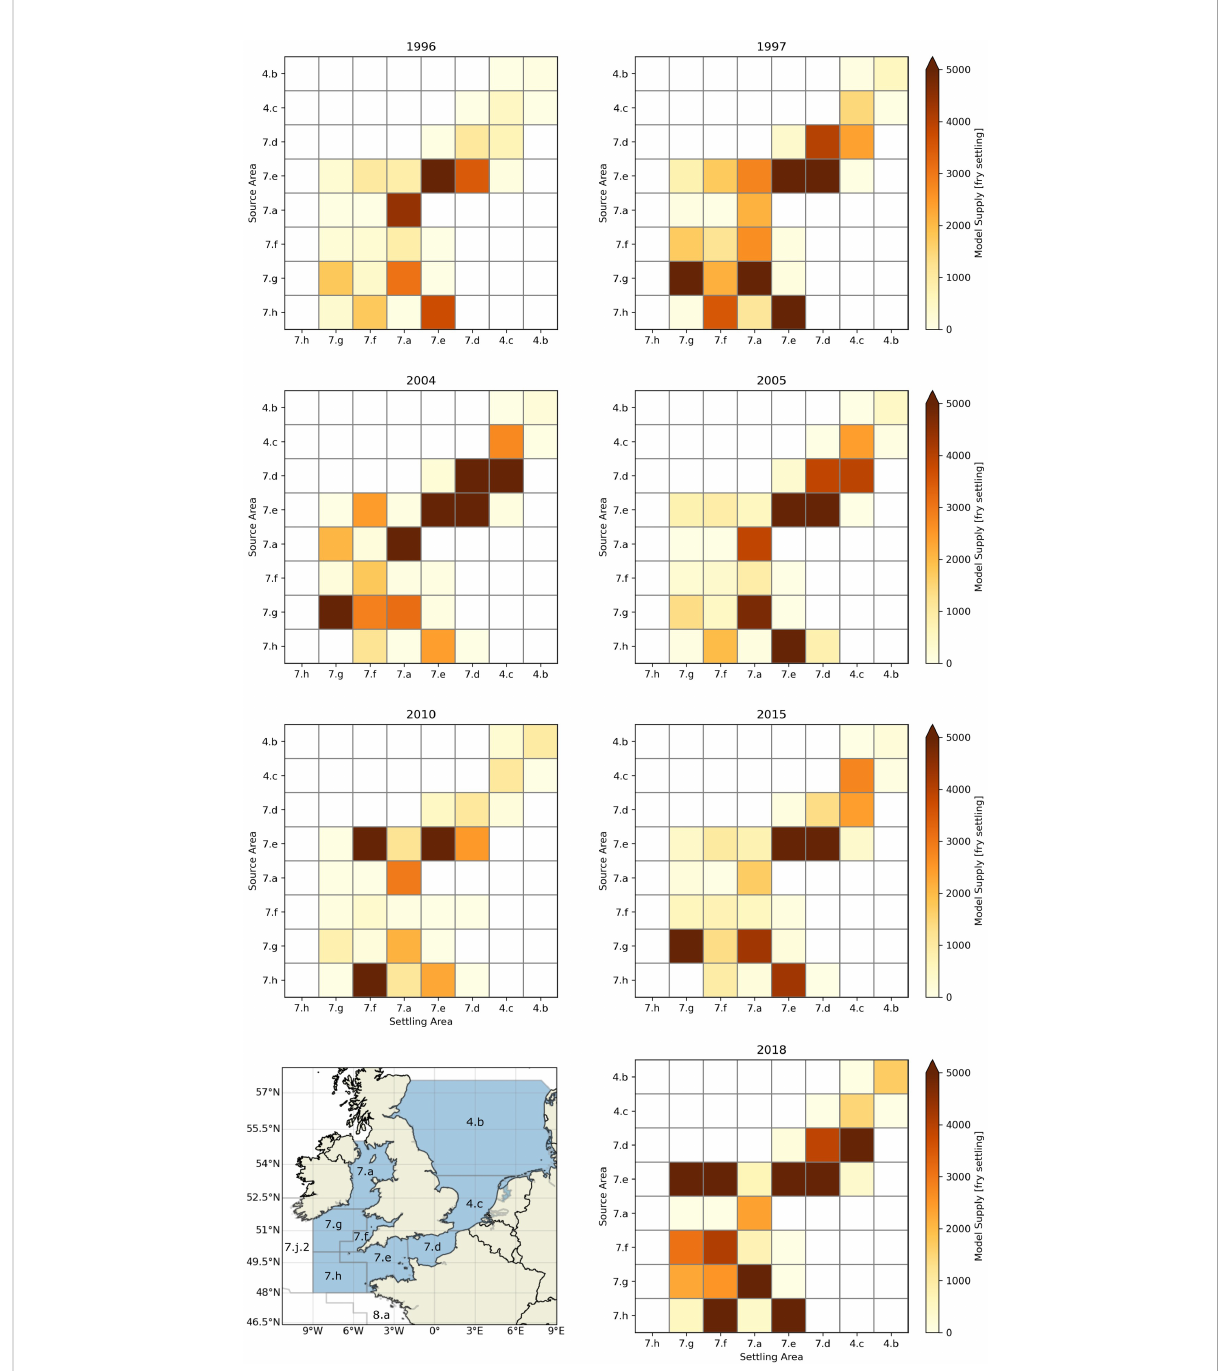
FIGURE 10 Connectivity matrix, showing model supply of fry sourced (as eggs, attributed to each particle) and settling within ICES areas for the northern stock (7.a, d-h, 4.b-c). Location of each area is shown in lower left panel (shaded in blue). Values along the diagonal indicate spawning and settling within the same area. White boxes indicate zero particles